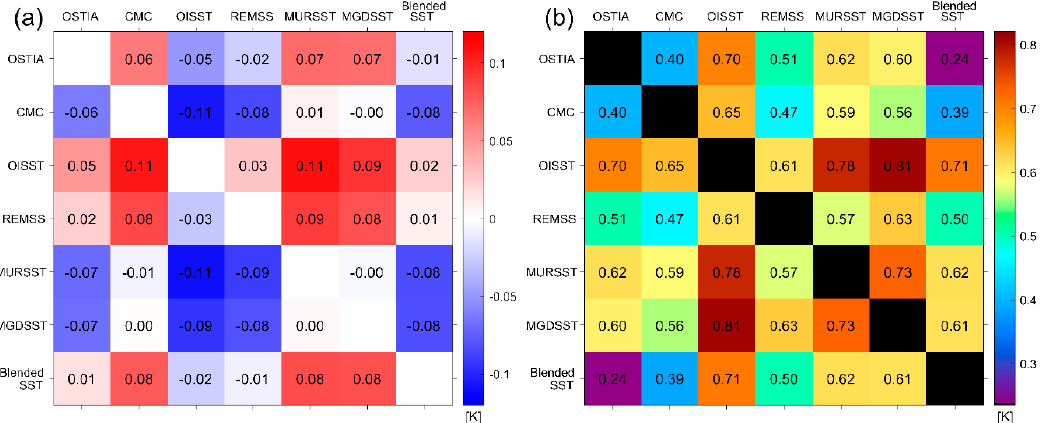
Figure 9. ( a ) Bias errors and ( b ) root-mean-squared errors of sea surface temperature (SST) analysis (column) estimated using other SST analysis (row) as reference. The errors were obtained for SST di ff erences by subtracting one SST product on the left side from the other SST product listed at the top.